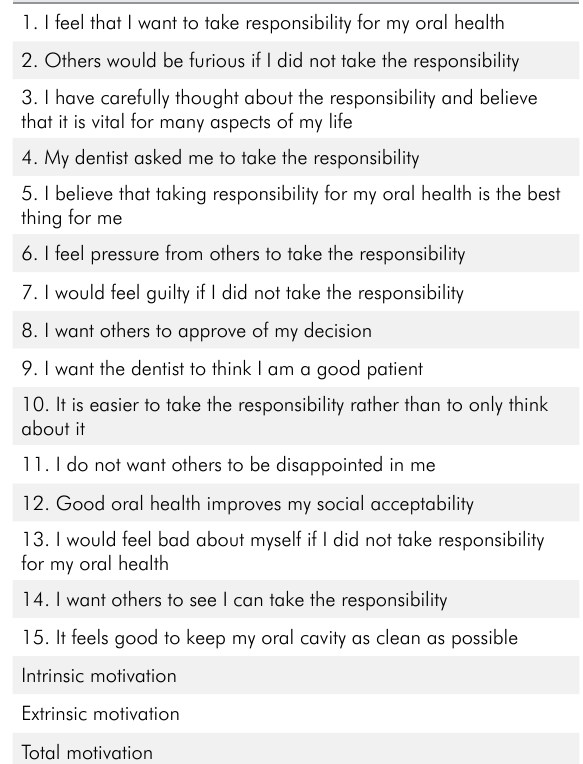
Table 1. DTMS treatment-seeking questionnaire DTMS Treatment-seeking